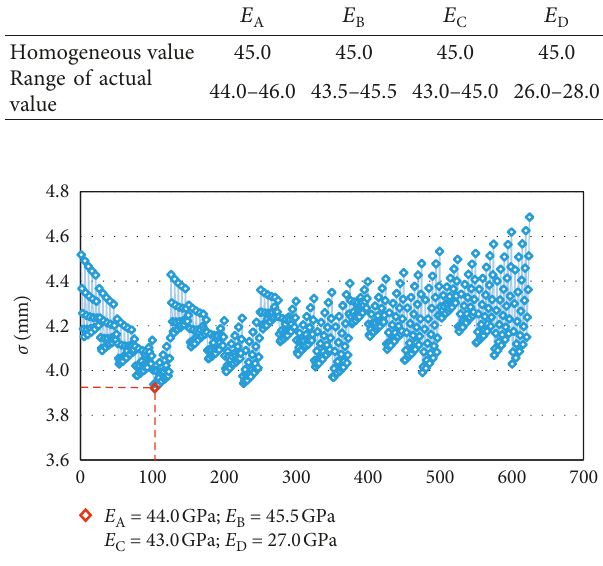
Figure 14: Standard deviation of combined results of E E D with the PSOGSA-SVM